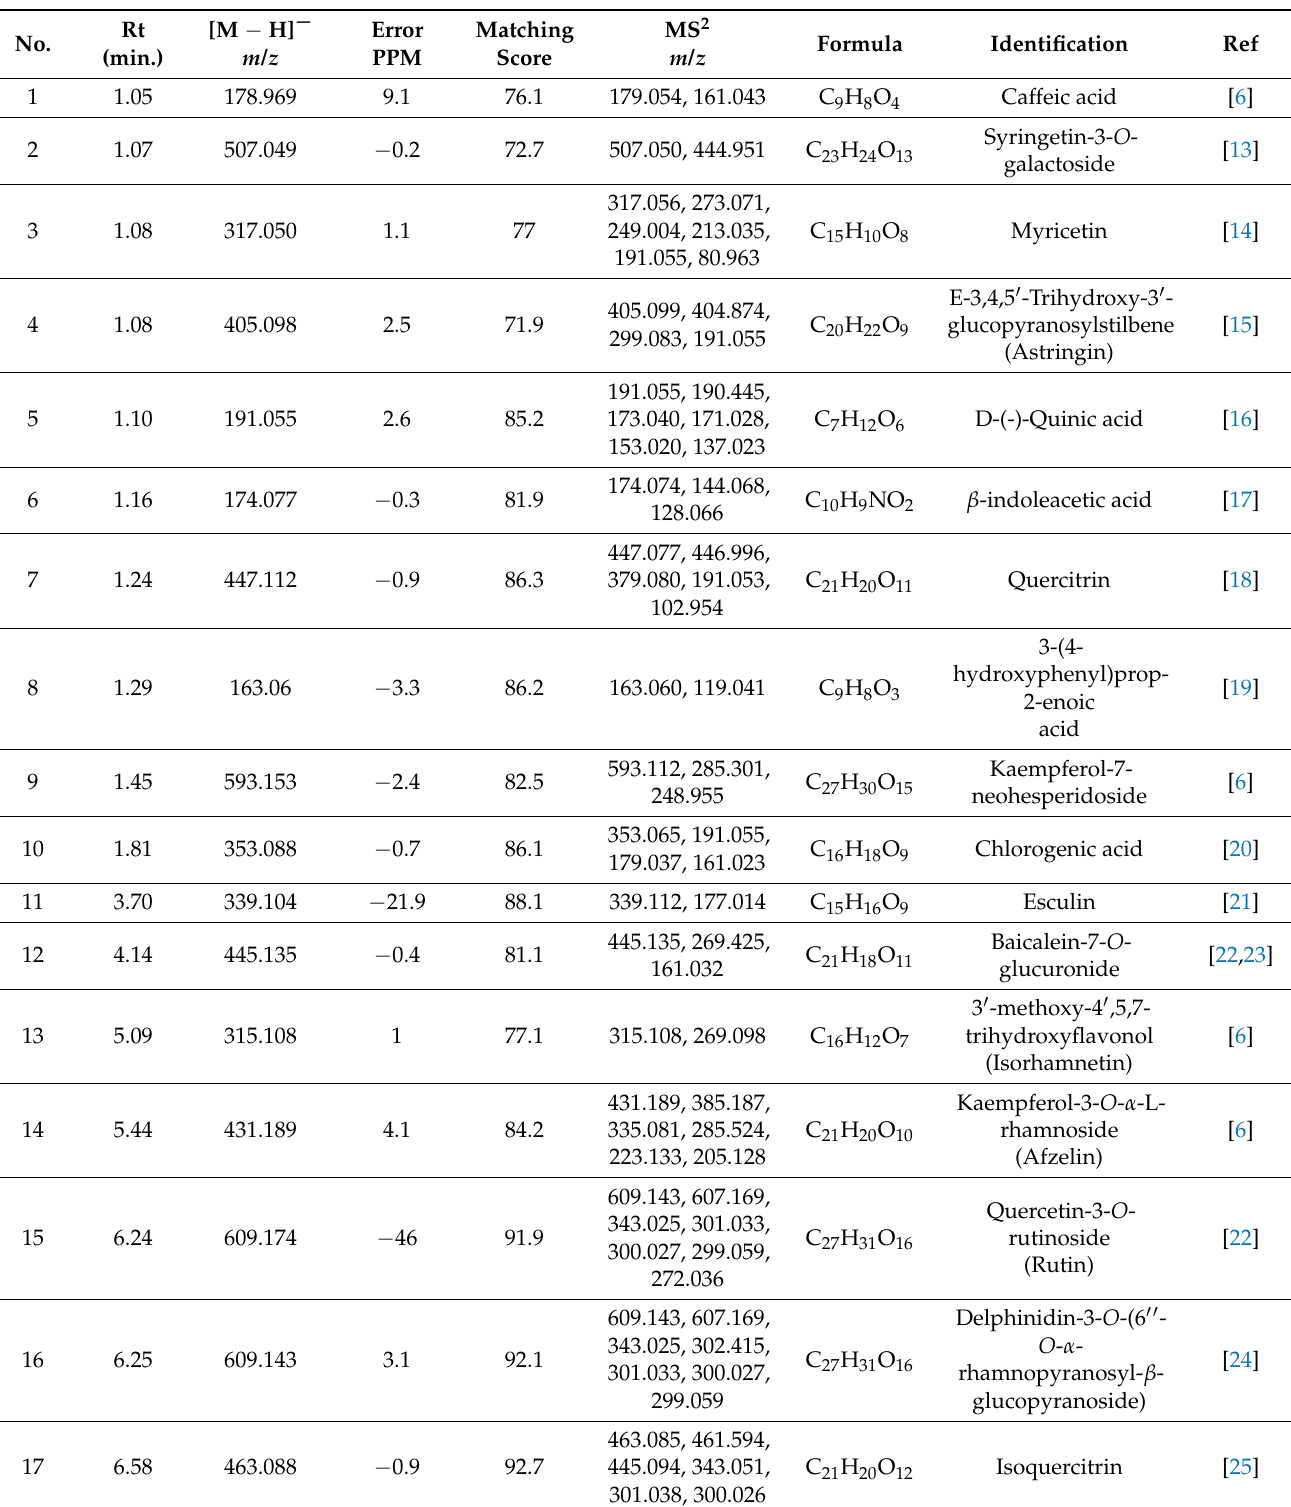
Table 1. Phytochemical profiling of G. thunbergia methanol extract of leaves by LC–ESI–MS/MS in negative ion